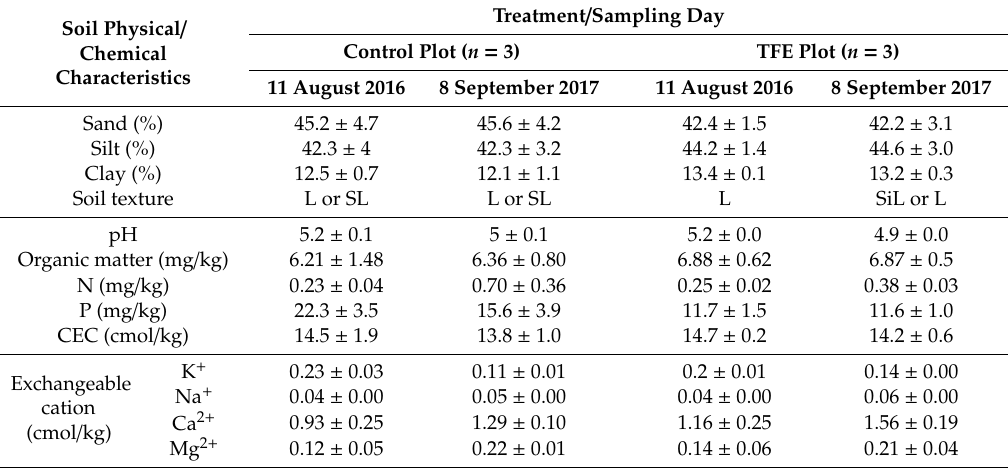
Table 2. Soil physical and chemical properties (Avg. ± S.E.) in the control and TFE plots during the TFE